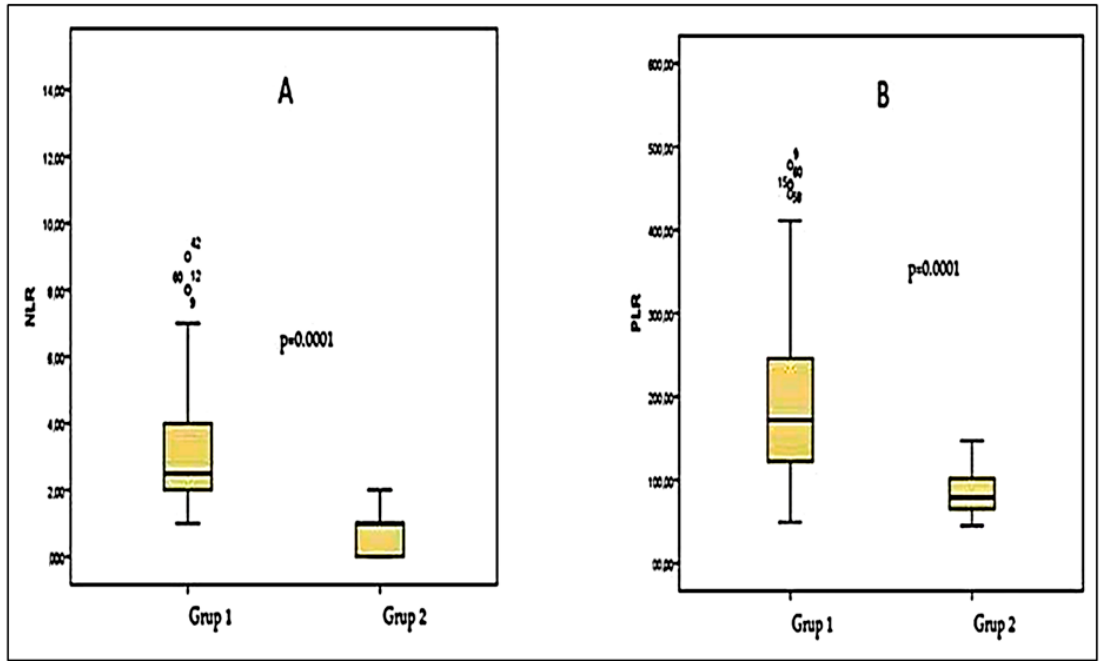
Figure 1. ( A ) The comparison of NLR (neutrophile/lymphocyte ratio) values in Group 1 (lung cancer patients) and Group 2 (control cases); ( B ) The comparison of PLR (platelet/lymphocyte ratio) values in Group 1 and Group 2.